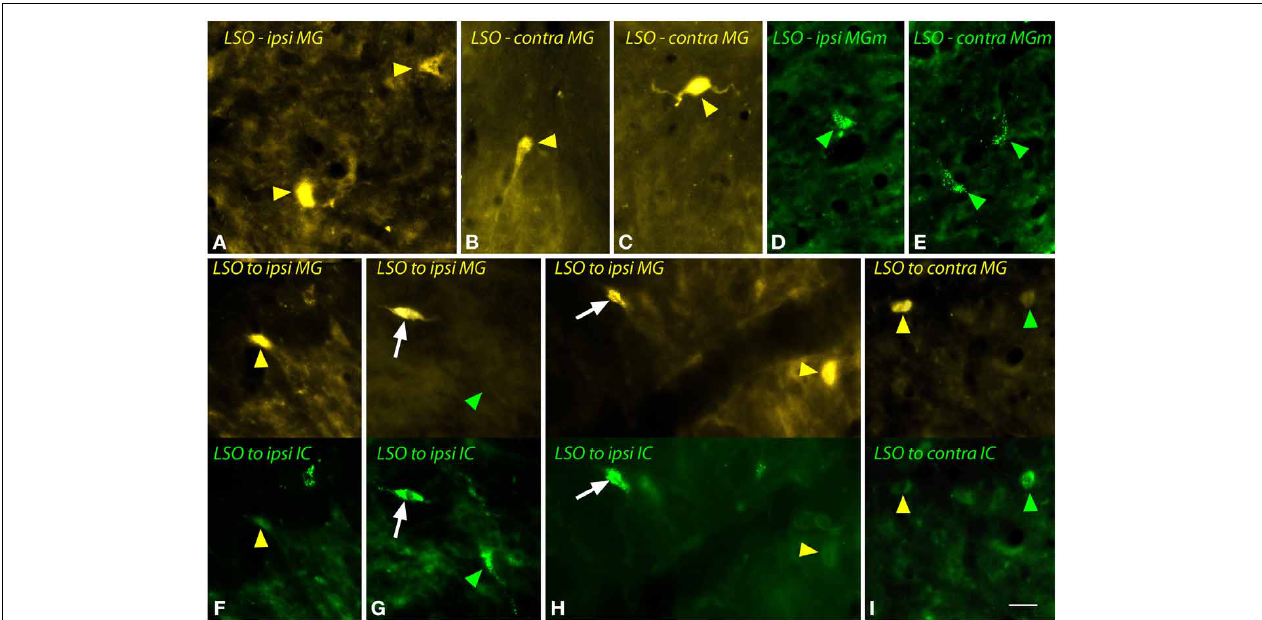
FIGURE 4 | Photomicrographs showing labeled cells in the lateral superior olivary nucleus (LSO) after injections into the medial geniculate nucleus (MG) and the inferior colliculus (IC). (A–C) Cells labeled by a large injection of FluoroGold into the left MG (GP597). Labeled cells (yellow arrowheads) are shown ipsilateral (A) or contralateral (B,C) to the injection site. (D,E) Cells labeled by a small injection of green beads into the right MG medial subdivision (MGm). Labeled cells (green arrowheads) are shown ipsilateral (D) and contralateral (E) to the injection site (GP689). (F–I) Single- and double-labeled cells in the LSO after injections of FluoroGold into the left MG and green beads into the left IC